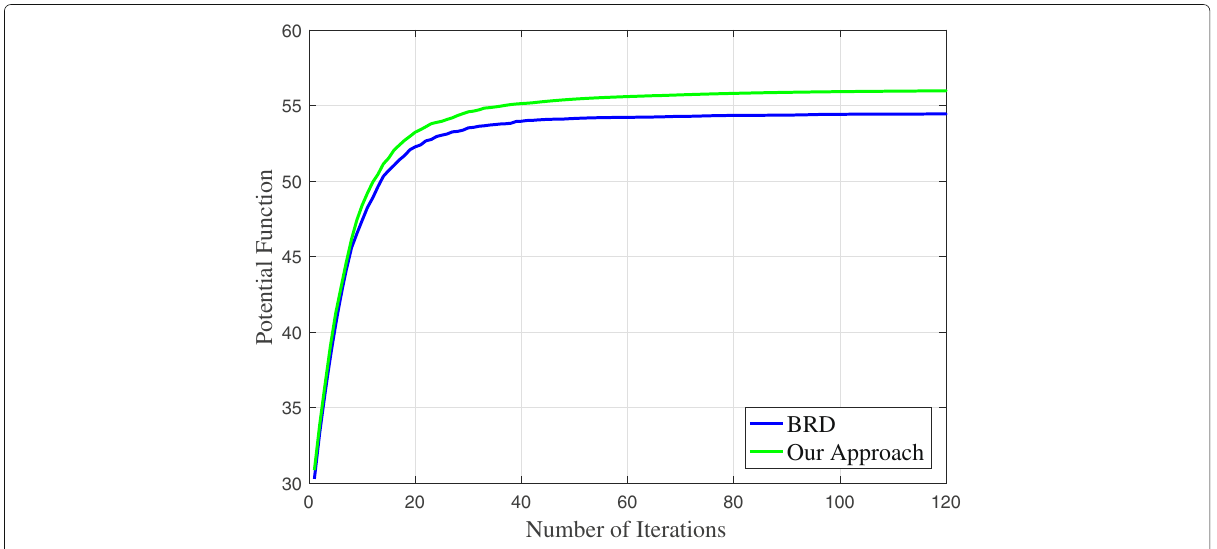
Fig. 3 The comparison results of the convergence performance of Algorithm 1 and BRD with fixed a (cid:5)